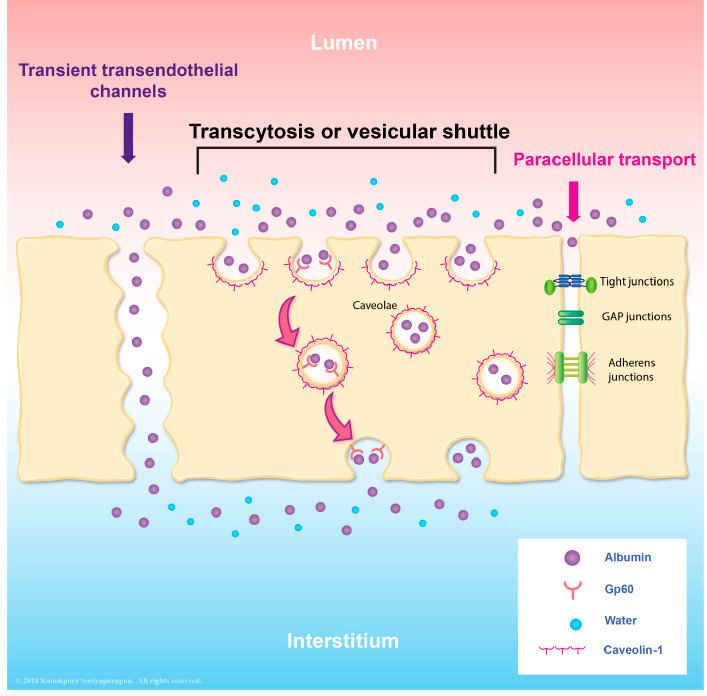
Figure 1. Illustration describing the vesicular transport of albumin. There are several transport pathways, including paracellular transport of molecules through the cell junction. Another pathway is transcytosis, which includes the transendothelial channels and vesicular shuttle. Transcytosis occurs via fusion-fission model or via binding between gp60 and albumin molecules which are mediated via